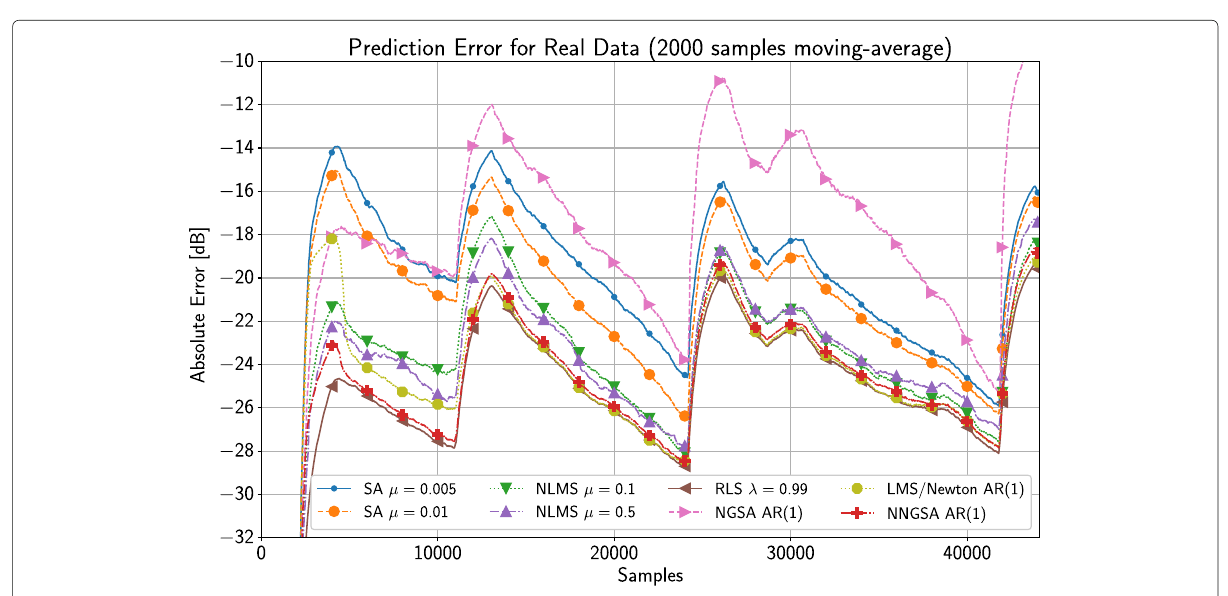
Fig. 8 AE comparison for real music